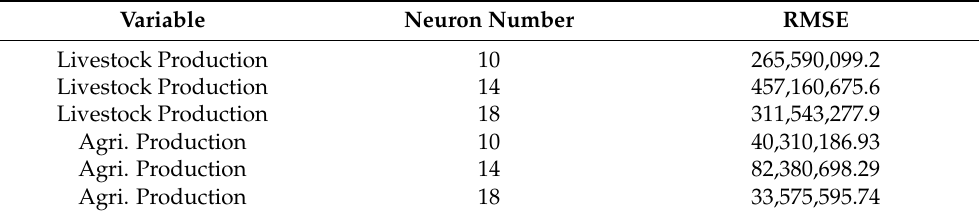
Table 4. RMSE results for MLP models with different numbers of neurons in the testing phase.